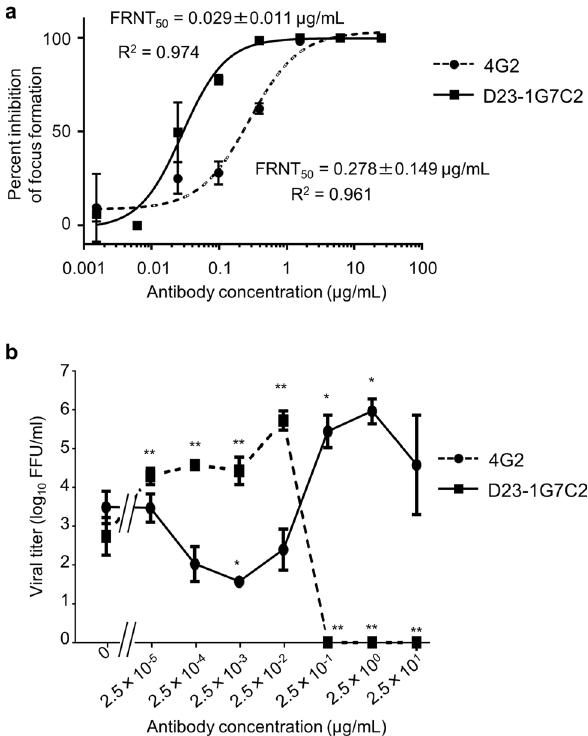
Figure 3. In vitro assessment of antibody-dependent neutralization and enhancement of chimeric flavivirus infection. ( a ) To assess antibody (Ab)-mediated neutralization of virus, mouse monoclonal Ab 4G2 and human monoclonal Ab D23-1G7C2 were each serially diluted to 25, 6.25, 1.56, 0.39, 0.98, 0.024, 0.006, and 0.0015 µg/ mL and incubated with 150 focus-forming units (FFU) per well of DV2ChimV. Ab-virus mixtures were then assessed in focus-forming assays to determine the 50% focus reduction neutralization test (FRNT 50 ) values of the Abs, which were 0.278 µg/mL for 4G2 and 0.029 µg/mL for D23-1G7C2. FRNT 50 was calculated from nonlinear log-dose–response curves using GraphPad Prism software. Results are expressed as mean + SD of triplicate experiments. ( b ) To assess Ab-mediated enhancement of infection, 4G2 was serially diluted by tenfold dilution from 2.5 × 10 1 µg/mL to 2.5 × 10 −5 µg/mL, and incubated with 4 × 10 4 FFU of DV2ChimV. Peritoneal- exudate cells were infected with virus–Ab mixtures, at a multiplicity-of-infection of 0.1, and incubated for 3 days. The level of release of viruses into the culture supernatant was determined by titration in Vero cells. Results are expressed as mean + SD of triplicate experiments. Viral titers of each group were analyzed by one- way ANOVA after log transformation. Significance of the levels was calculated relative to Ab untreated by the Dunnett’s Multiple Comparison Test. * p < 0.01, ** p <